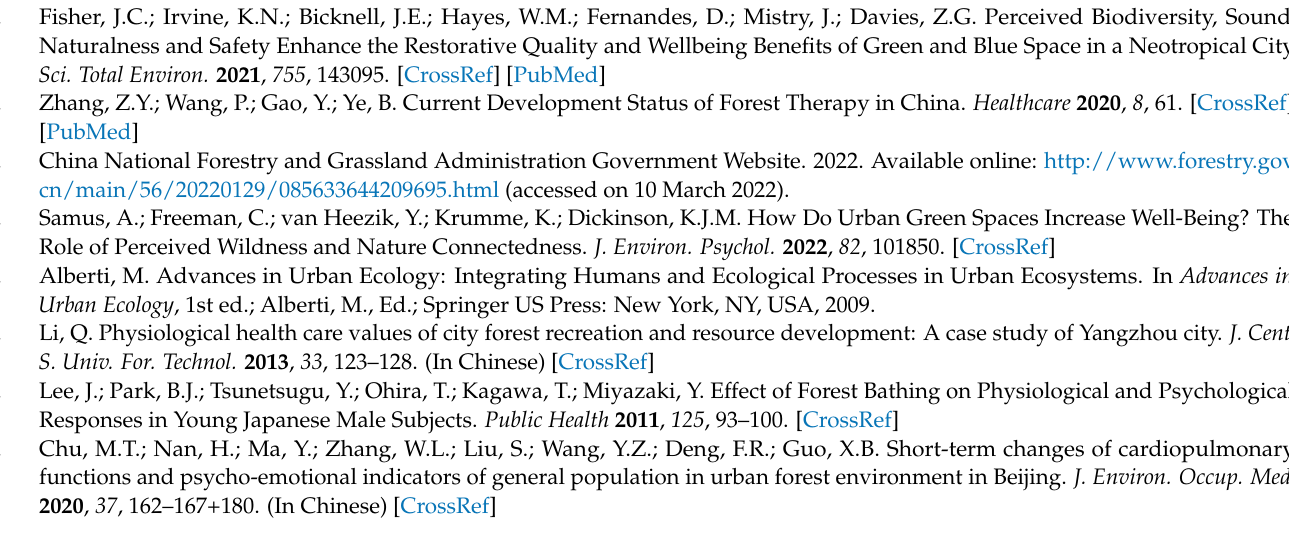
Figure A2. The relationship between landscape perception and physical and mental recovery in different autumn spaces. ( A-1 ) Autumn dynamic water landscape. ( A-2 ) Autumn static water landscape. ( A-3 ) Autumn lookout landscape. ( A-4 ) Autumn coniferous forest landscape. ( A-5 ) Autumn broadleaved forest landscape. ( A-6 ) Autumn mixed forest landscape. * p < 0.05; ** p < 0.01; *** p < 0.001. SBP: systolic blood pressure. This character was created by Chen Rui.